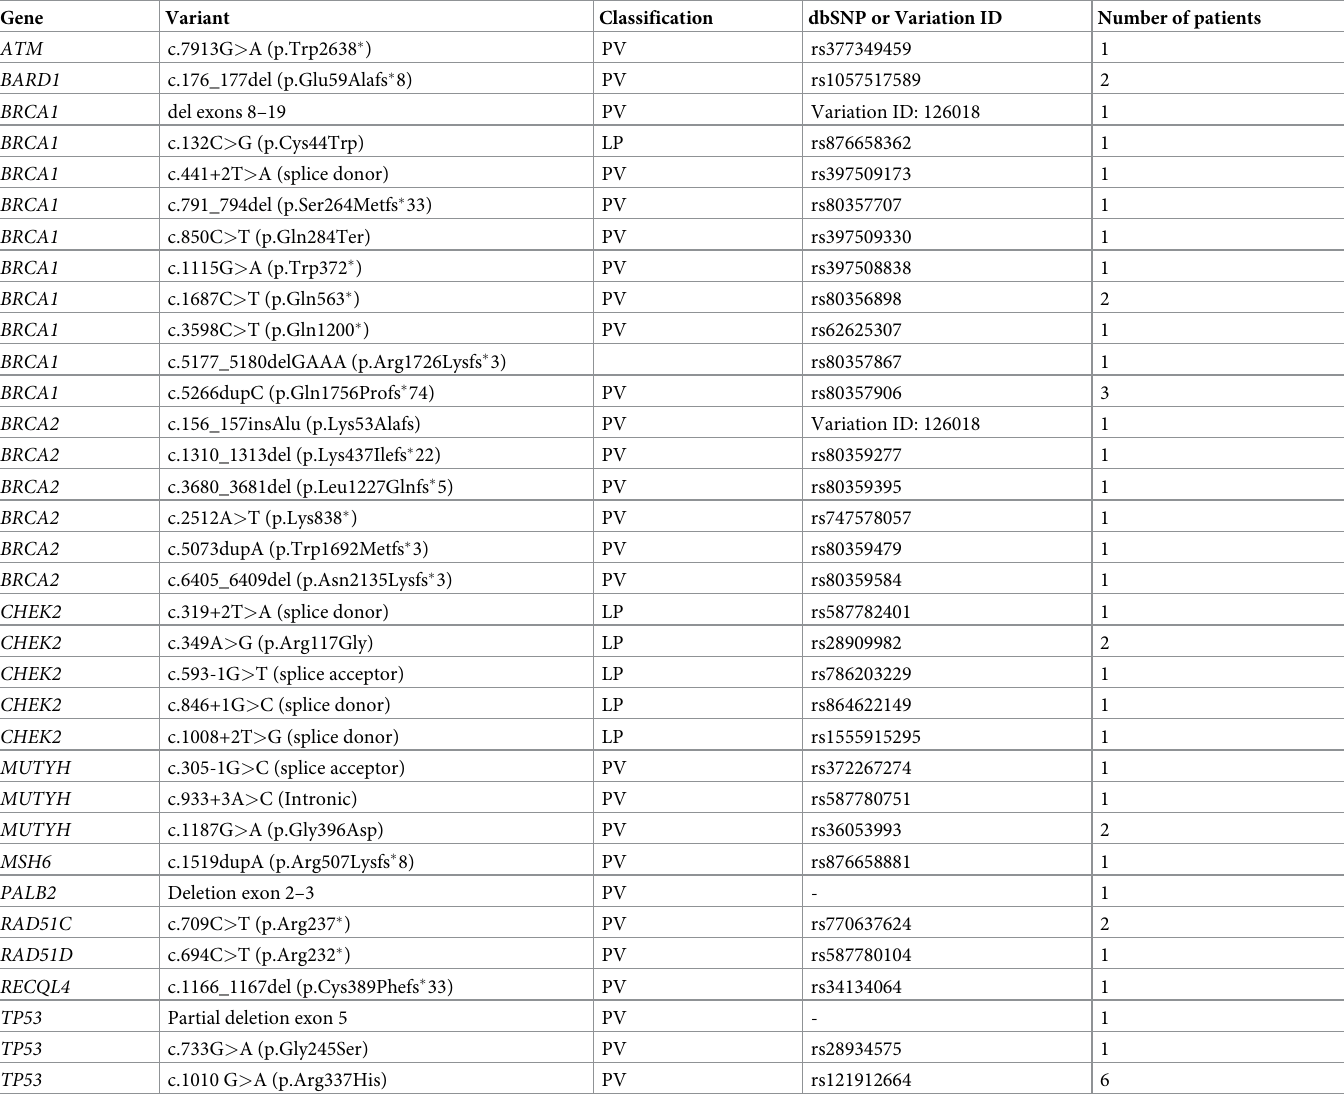
Table 2. Pathogenic and likely pathogenic variants